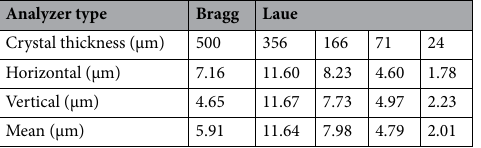
Table 1. FWHMs of the LSF in the horizontal and vertical directions of the circular structure in the numerical phantom shown in Fig. 4.